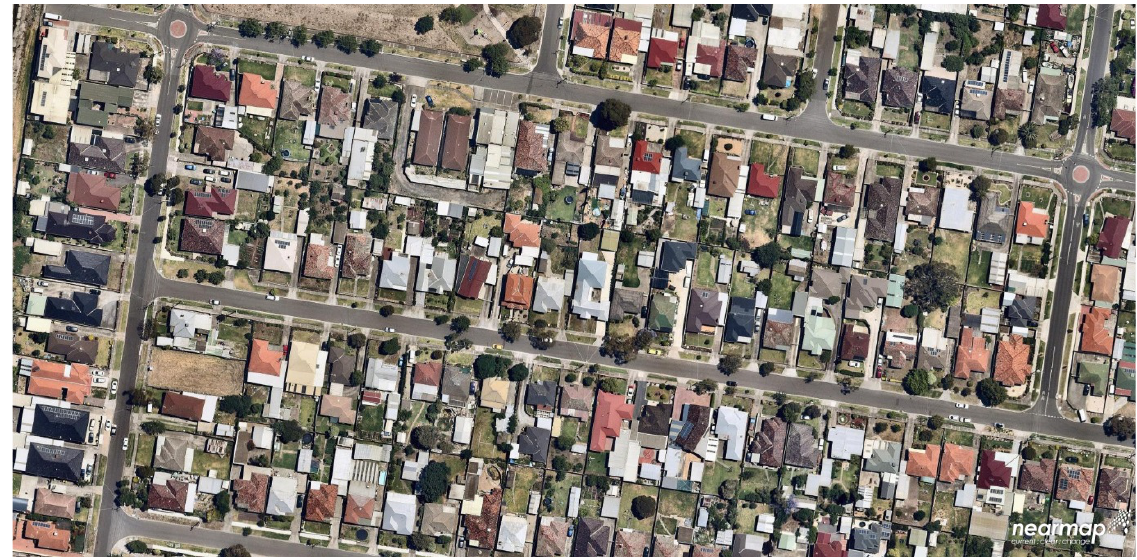
Figure 3: Large plots of land with gardens (Source: